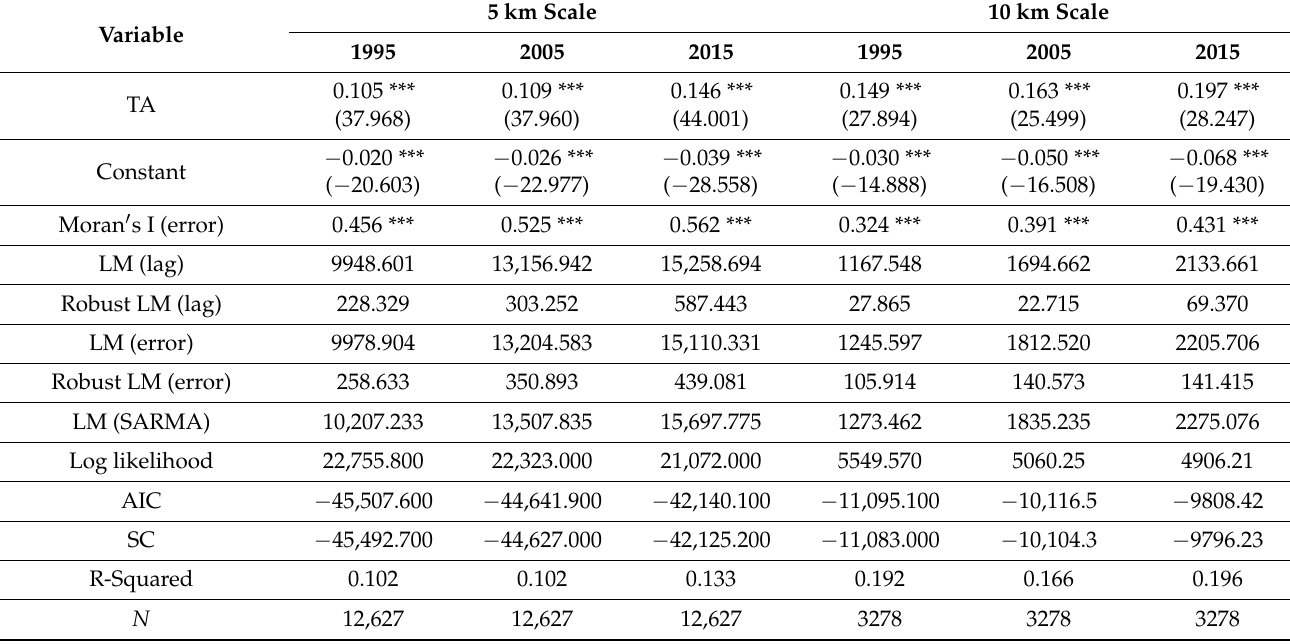
Table 1. Regression results of the ordinary least squares (OLS): 1995, 2005, and 2015.